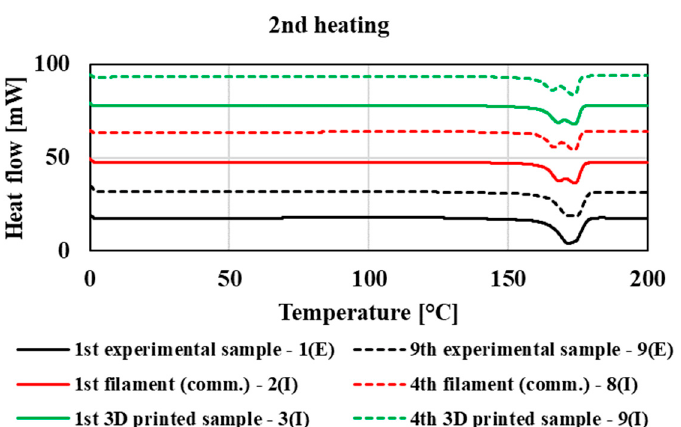
Figure 14. DSC thermogram of 2nd heating for experimental and commercial type polymeric material. Table 3. Thermophysical characteristics of studied samples (processing passes).